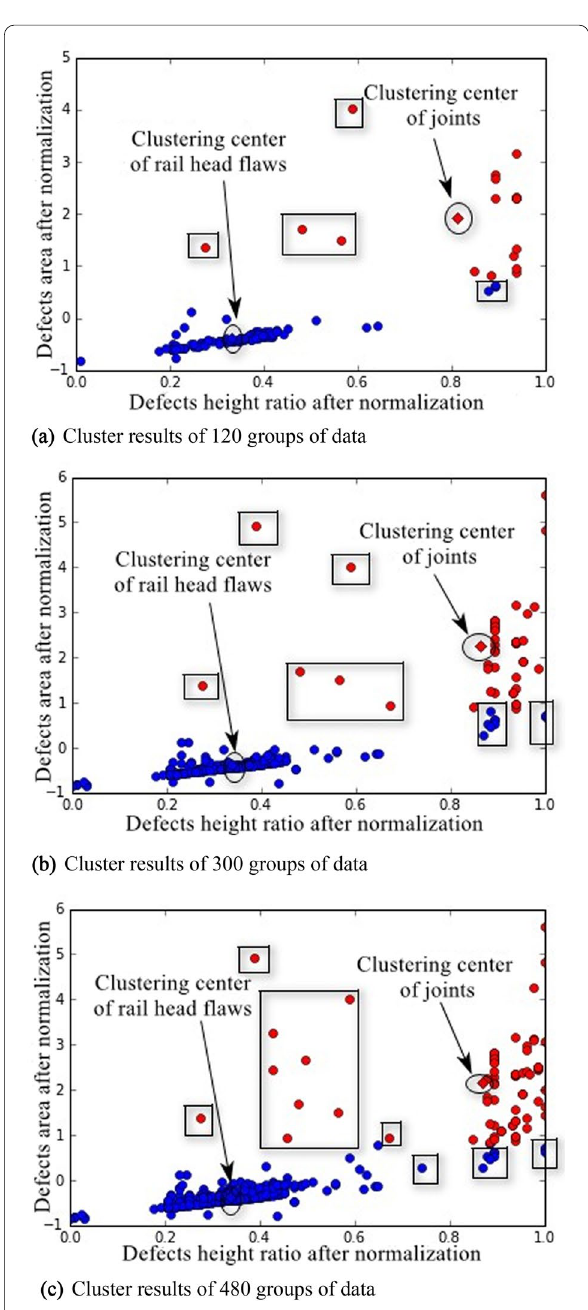
Figure 17 Clustering results of main defect in rail head